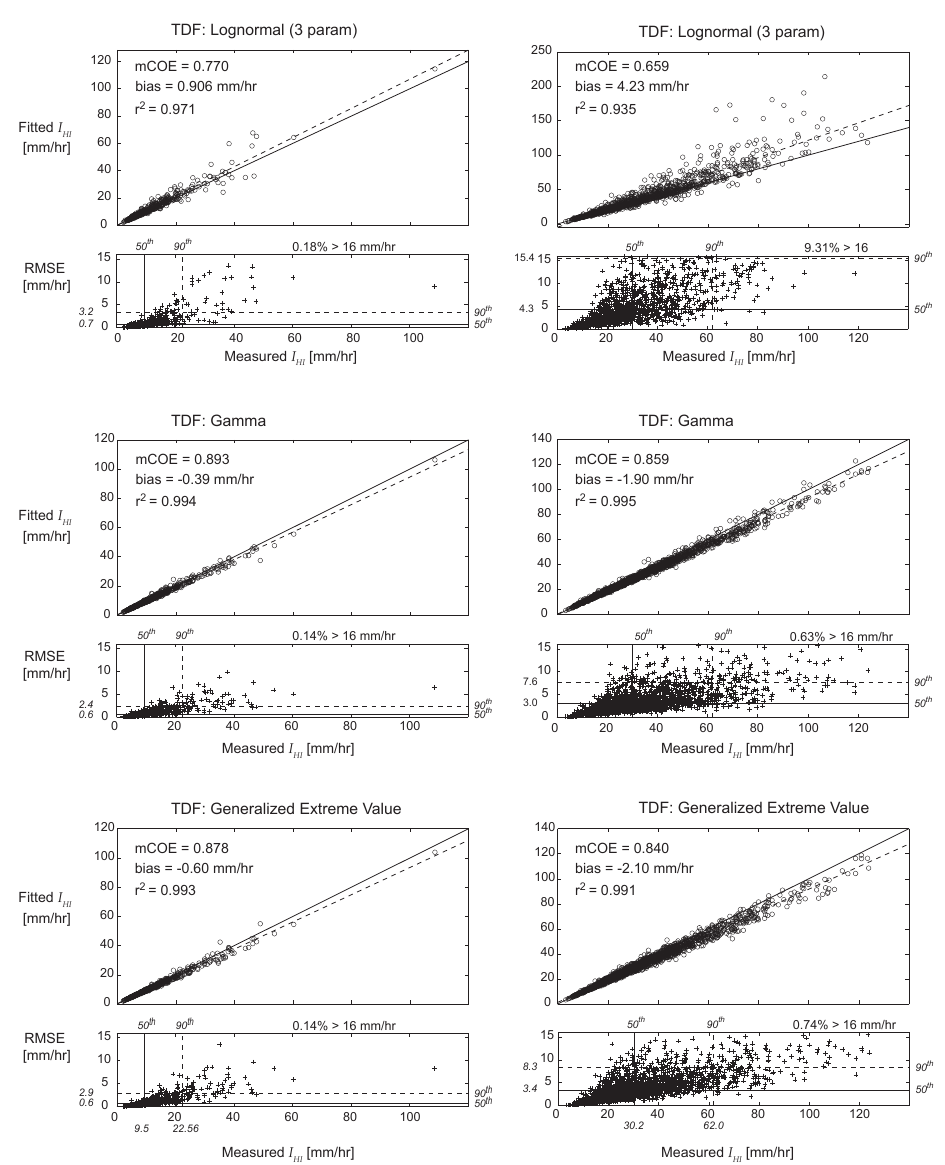
Fig. 4. Six paired scatter plots are shown to illustrate the skill of three selected TDF’s: three parameter Lognormal (top); Gamma (middle); and the Generalized Extreme Value (lower). The data is for two pluviograph stations: Melbourne on the left and Darwin on the right. The plots are in pairs showing the fitted I 30 and the RMSE for each event (both plotted versus the measured I 30 ) . Values for mCOE, bias and the square of Pearson’s correlation coefficient ( r 2 ) , as well as the line-of-perfect-agreement (solid) and the linear regression line (dashed) are printed on the I 30 charts. The RMSE plots indicate the 50th (solid line) and 90th (dashed line) percentile RMSE and measured I 30 values, and also indicate the percentage of RMSE values greater than 16mmh − 1 and are hence outside the vertical scale of the